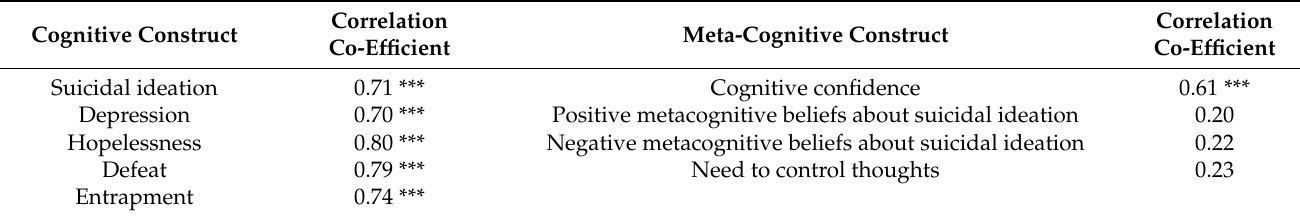
Table 4. Spearman’s correlation co-efficients for associations between trait and state level